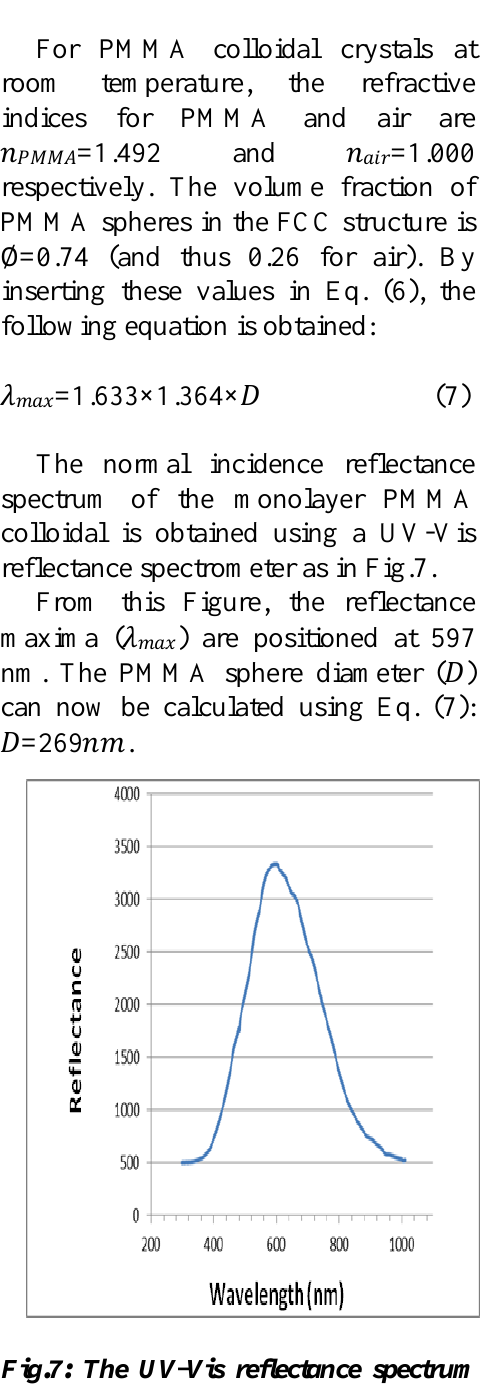
Fig.7: The UV-Vis reflectance spectrum of the monolayer PMMA